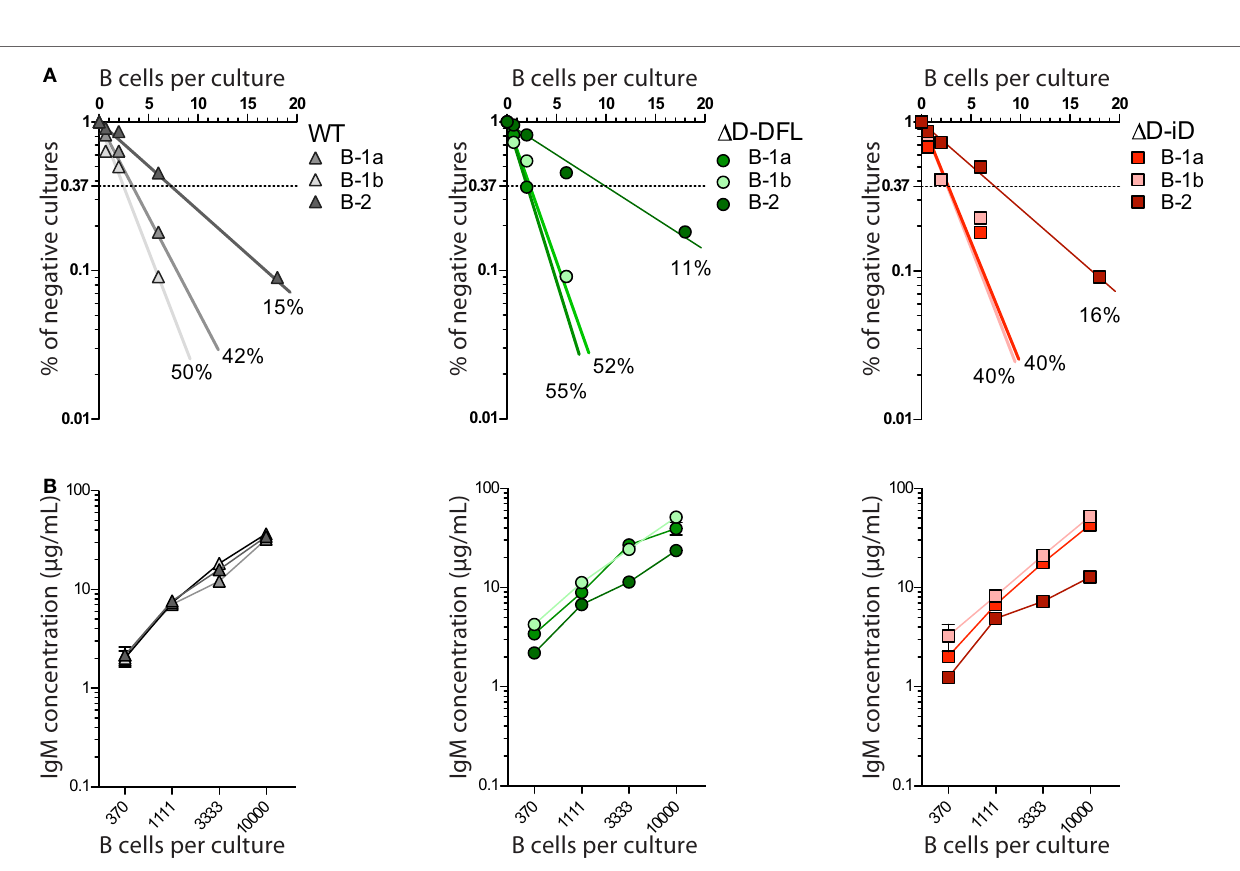
FigUre 2 | D h -altered B cells response to polyclonal stimuli . (a) Frequencies of response to LPS of PerC B cell subsets of each mouse strain were calculated by limiting dilution analysis. Presence of IgM in culture supernatants of 18, 6, 2, and 0.66 cells/culture on day 7 was assessed by ELISA. (B) IgM production by each PerC B cell subset in culture was measured by ELISA on culture supernatants of increasing number of cells/culture (370, 1111, 3333, and 10,000 cells/culture). PerC B-1a cells were sorted as B220 lo CD5 + , B-1b as B220 lo CD5 − Mac-1 lo/ + , and PerC B-2 cells were sorted as B220 hi CD5 − Mac-1 − . All cultures received 30 μ g/mL of LPS and 5 × 10 3 S17 feeder cells. Supernatants were collected on day 7.